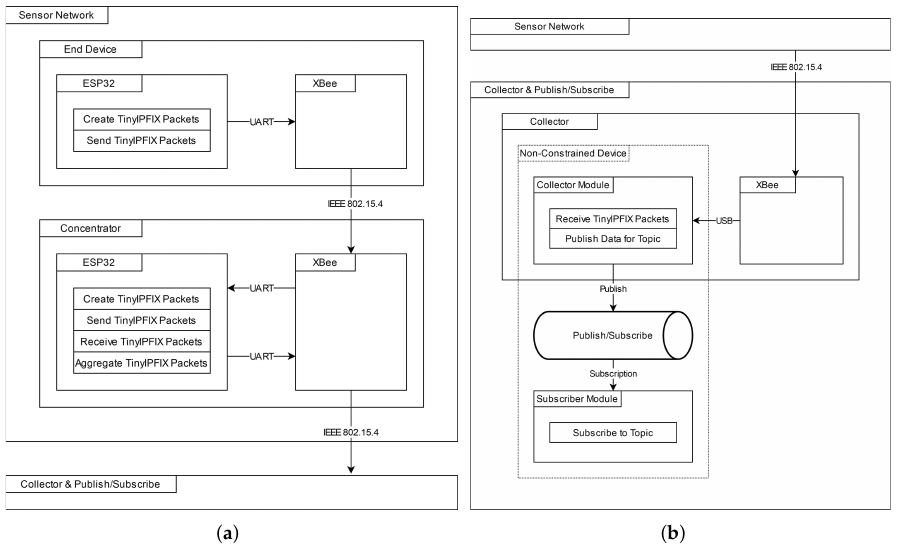
Figure 2. Interactions in the Network. ( a ) Sensor Network. ( b ) Collector and Publish/Subscribe